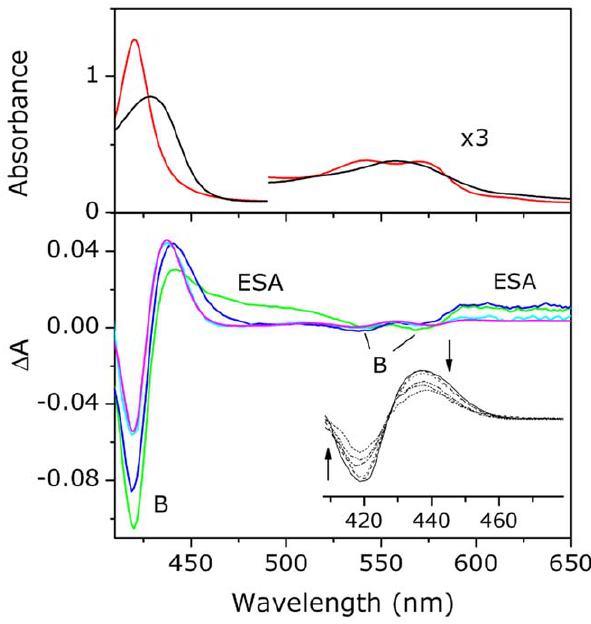
Figure 1. Transient absorption spectra. Top : Steady-state absorp- tion spectra of the CO complex of the Tf -trHb (red line) and the ferrous 5c-protein (black line). The protein concentration is 36 m M (2 mm path length cell). Bottom : Transient absorption spectra of the CO complex of the Tf -trHb excited at 400 nm with femtosecond pulses (ener- gy=0.5 m J): at 200 fs (green line), at 1 ps (blue line) and at 40 ps (cyan line) delay times. The latter is perfectly overlapped with the scaled steady-state difference spectrum between the CO and the ferrous 5-c spectra (magenta line). B: Bleaching; ESA: excited state absorption. Inset : transient absorption spectra from 40 ps until 1.5 ns. The time evolution of the signal is shown by the arrows.